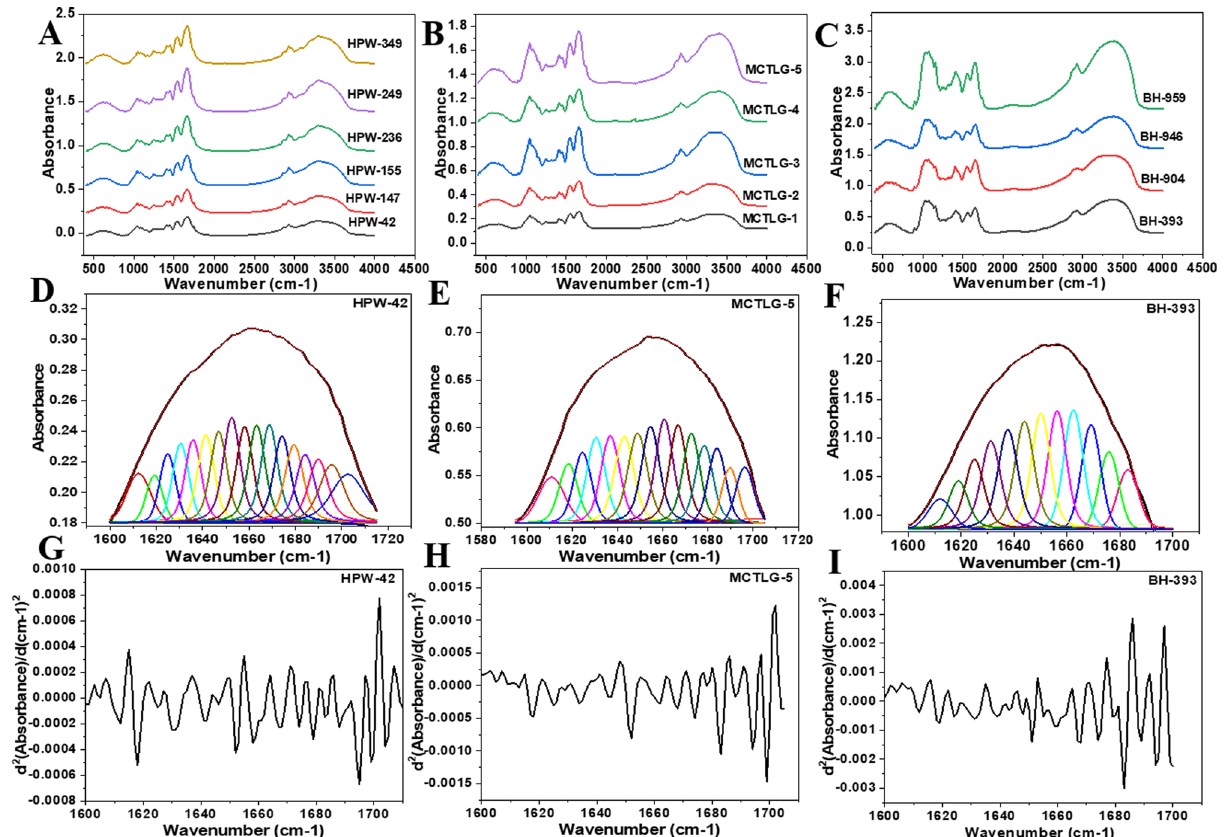
Figure 3. Original FTIR spectra of extracted prolamin ( A ) Gliadin, ( B ) Secalin, ( C ) Hordein; while Fourier- deconvoluted spectra in amide I region (1600–1700) of ( D ) HPW-42 Gliadin, ( E ) MCTLG-5 Secalin, ( F ) BH-393 Hordein; by confirming the peak positioned through their corresponding secondary derivative plot from ( G ) HPW-42 Gliadin, ( H ) MCTLG-5 Secalin and ( I ) BH-393 Hordein total hydrophobic AA group showed a non-significant (p ≥ 0.05) difference while the hydrophobic aromatic amino acids varied significant (p ≤ 0.05) at intra and inter cultivar level. The total neutral amino acids of prolamin fraction varied from 22.21–30.48% and consisted of non-polar, polar and aromatic amino acids which accounted for 11.33–18.79%, 6.55–9.69%, and 2.81–4.93% respectively. The polar AAs were higher in hordeins (7.50–9.50%) and secalins (7.46–9.69%), while lower in gliadins (6.55–8.59%) fraction. Similarly, the non-polar AAs were higher in hordeins (14.07–18.79%) and secalins (12.53–16.92%), while lower in gliadins (11.33–15.96%) fraction. Hordeins fraction from BH-393 and gliadins fraction from HPW-236 accounted for the highest and the lowest proportion of polar amino acids respectively. Whereas the highest proportion of non-polar AA was observed in hordeins fraction cv BH-902 and the lowest in gliadins fraction cv HPW-155. The neutral aromatic AAs were found to be highest in hordeins fraction, BH-393 and the lowest in secalins fraction, MCTLG-3. This implies that Tyr-Tyr covalent interactions speculated to be more in hordein which attributed to greater aggregation tendency than gliadin and secalin fractions 23 . The non-polar, polar, neutral aromatic and total neutral amino acids were observed to vary significantly (p ≤ 0.05) among prolamin fractions at inter and intra cultivar level except among wheat cultivars of neutral aromatic group where the values varied non-significantly (p ≥ 0.05). The variation in amino acid composition is considerably affected by genotype, irrigation practices, fertilizer application, and environmental conditions 53–58 . Secondary structure of prolamin fractions. The deconvoluted fitted curve and the relative amount of secondary structural components in amide I region (1600–1700) of extracted prolamin assigned to spe- cific absorption frequencies are presented in Table S2, Fig. 3 and Figure S5. The structural component posi- tioned between 1612–1624 cm −1 , 1630–1642 cm −1 , 1643–1648 cm −1 , 1649–1659 cm −1 , 1660–1685 cm −1 and 1686–1699 cm −1 has been assigned to inter-molecular β-sheet, β-sheet, random coil, α-helix, β-turn and β-turn + β-sheet secondary structure respectively 29,41,46,59 .